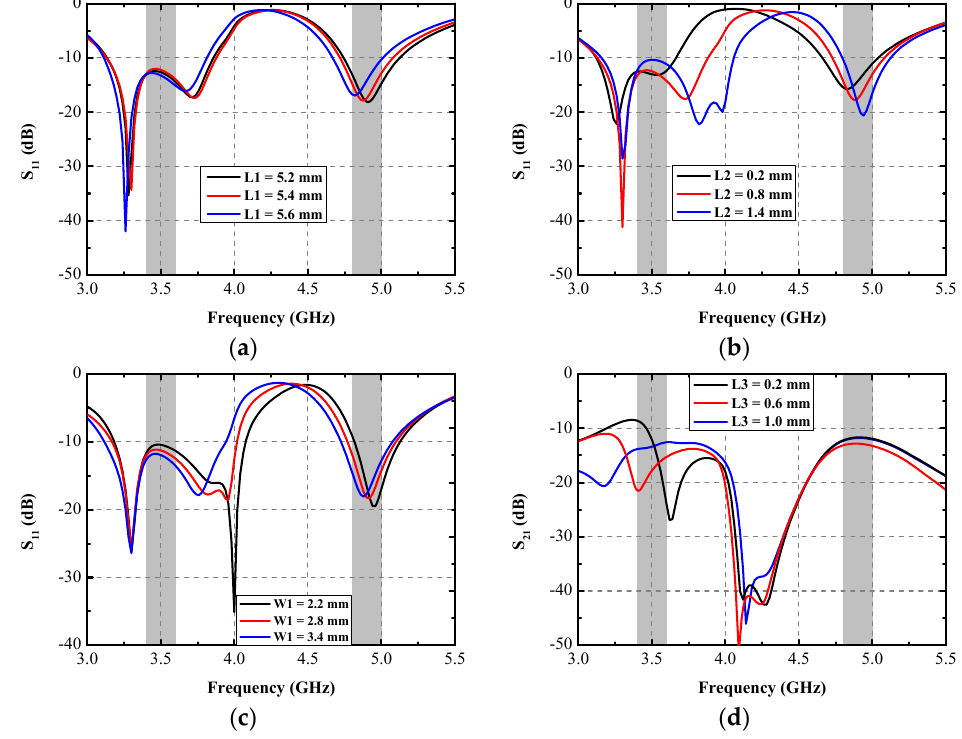
Figure 5. Simulated S 11 with various ( a ) L1 , ( b ) L2 , ( c ) W1 , and ( d ) S 21 with different L3